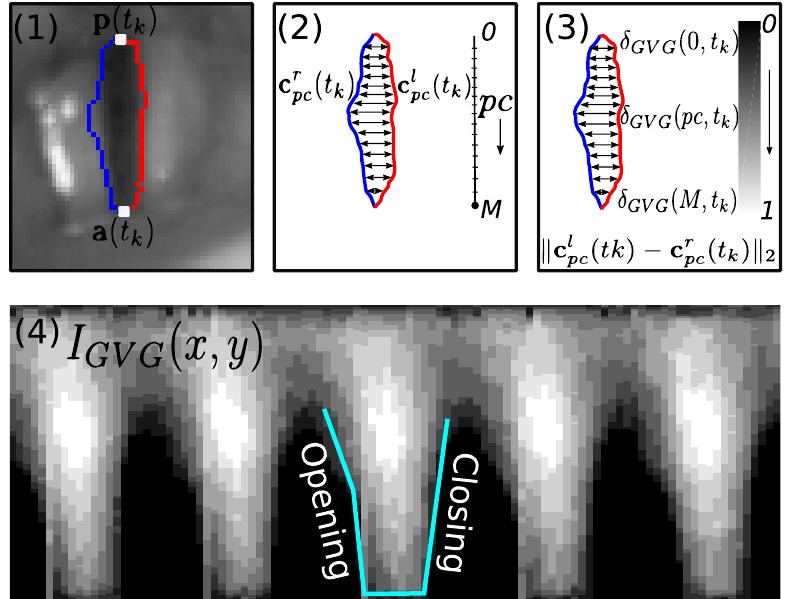
Figure 14. Schematic representation of the GVG playback. (1) Segmentation; (2) Resampling of the extracted vocal folds edges; (3) Computation of vocal fold deflections δ GVG ( pc , t k ) ; (4) I GVG ( x , y ) representing an HSV with five glottal